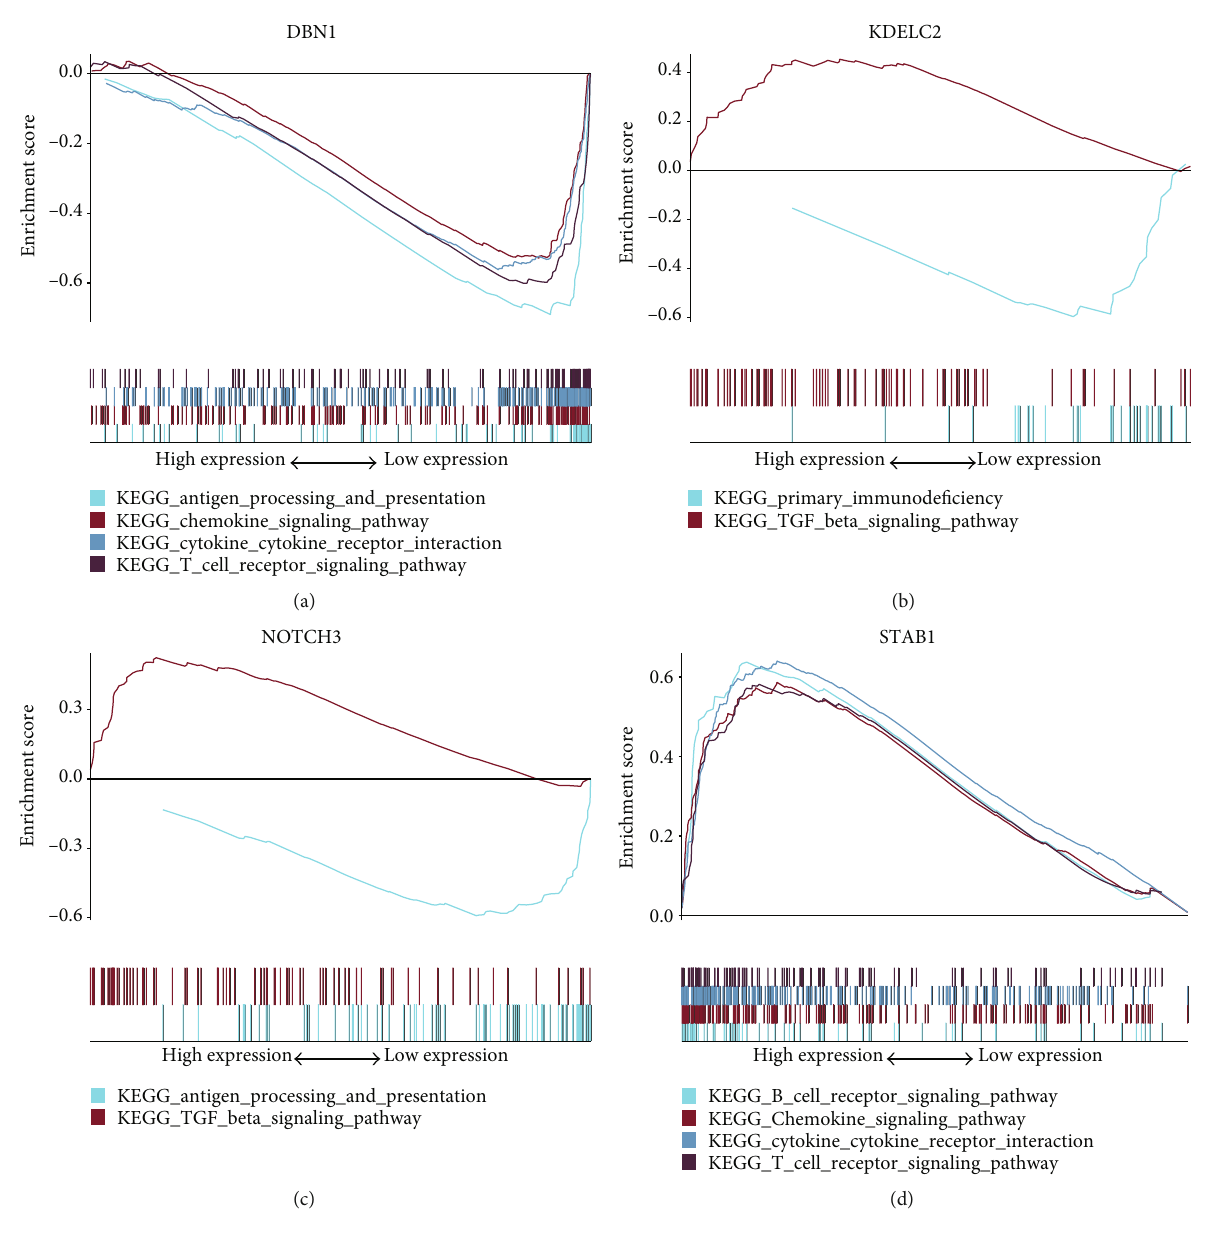
Figure 6: GSEA analysis. (a) DBN1 is enriched in antigen processing and presentation, chemokine signaling pathway, cytokine-cytokine receptor interaction, and T cell receptor signaling pathway. (b) KDELC2 is enriched in primary immunode fi ciency, TGF- β signaling pathway. (c) NOTCH3 is enriched in the antigen processing and presentation, TGF- β signaling pathway. (d) STAB1 is enriched in the B cell receptor signaling pathway, chemokine signaling pathway cytokine-cytokine receptor interaction, and T cell receptor signaling